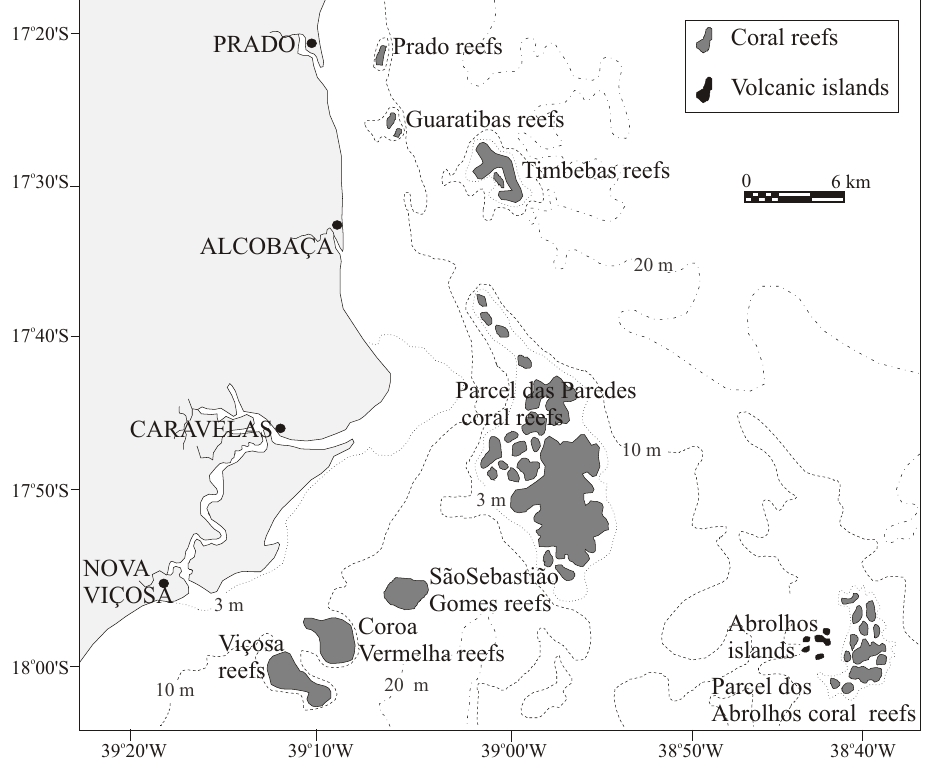
Fig. 2 – Morphology of the continental shelf adjacent to the Caravelas strandplain (modified from Dominguez et al.